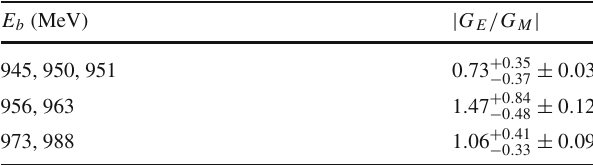
Fig. 8 The neutron | G E / G M | ratio measured using the 2019 data set. The left edge of the plot corresponds to the n ¯ n threshold, where | G / G | = 1 E M Table 2 The measured | G E / G M | values E b (MeV)